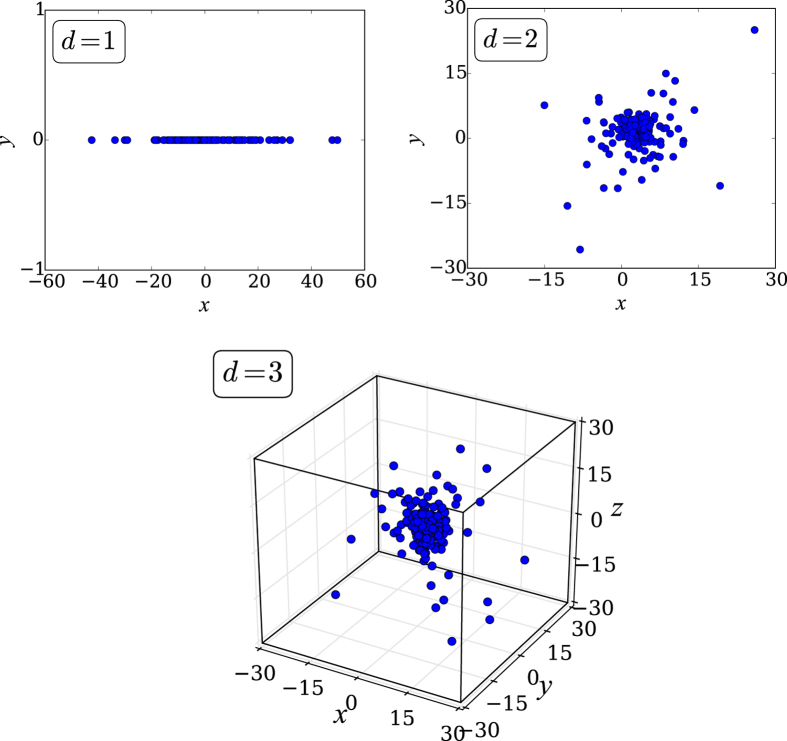
Distribution of N = 500 sites obtained with Eq. (1) for αA = 2.0, αG = 0.0, and d = 1, 2, 3.